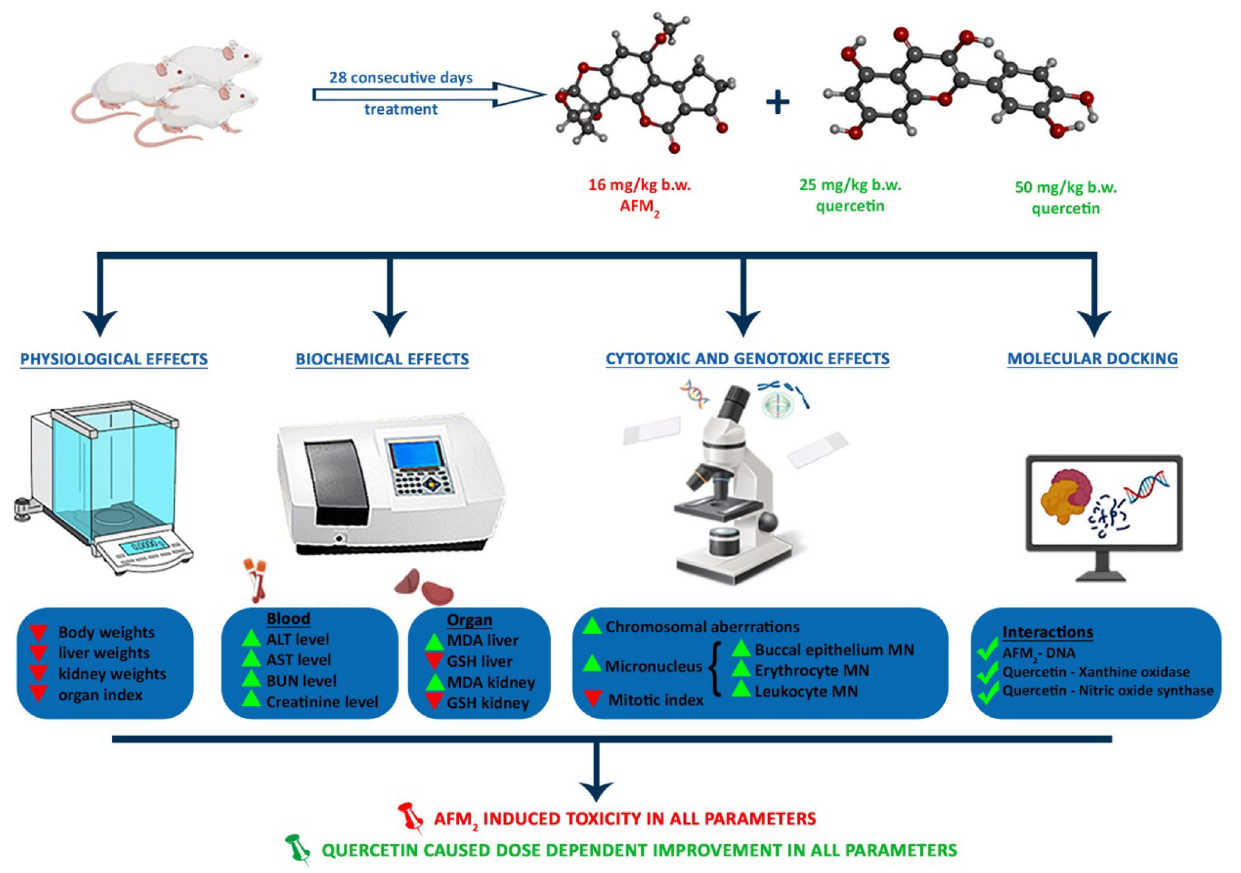
Figure 9. Experimental design and summary of